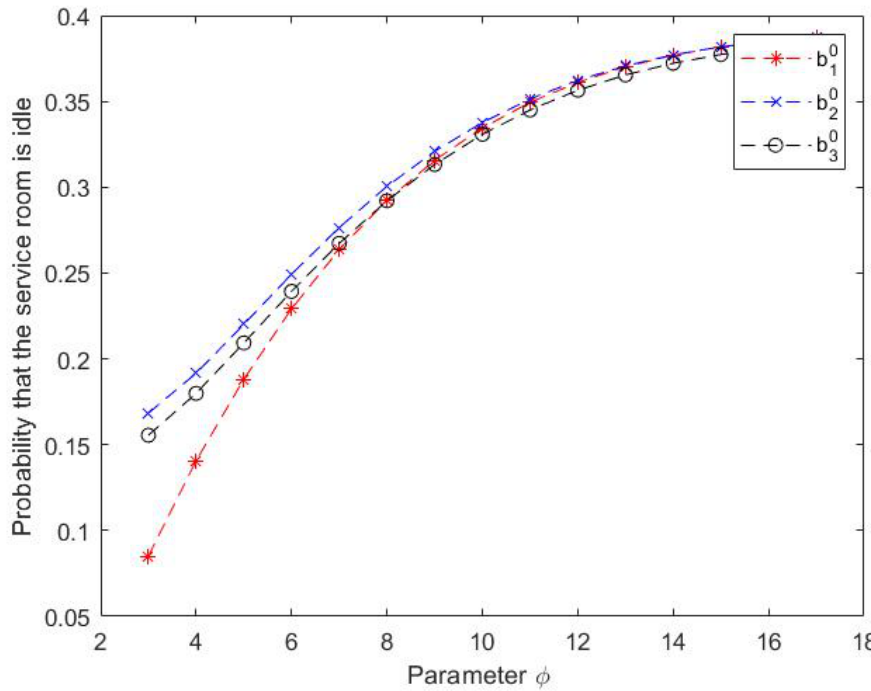
Figure 4. Effect of φ on probability that the service room is